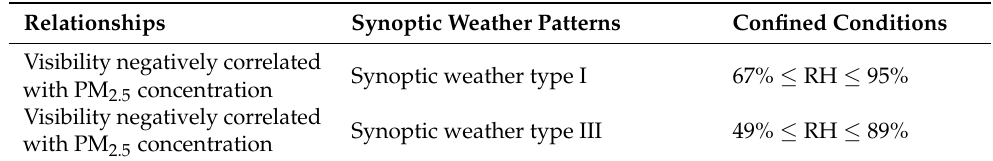
Table 7. Confined ranges of the correlations between visibility and RH, and mean PM 2.5 concentration during the winter in the Taipei metropolis from 2016 to